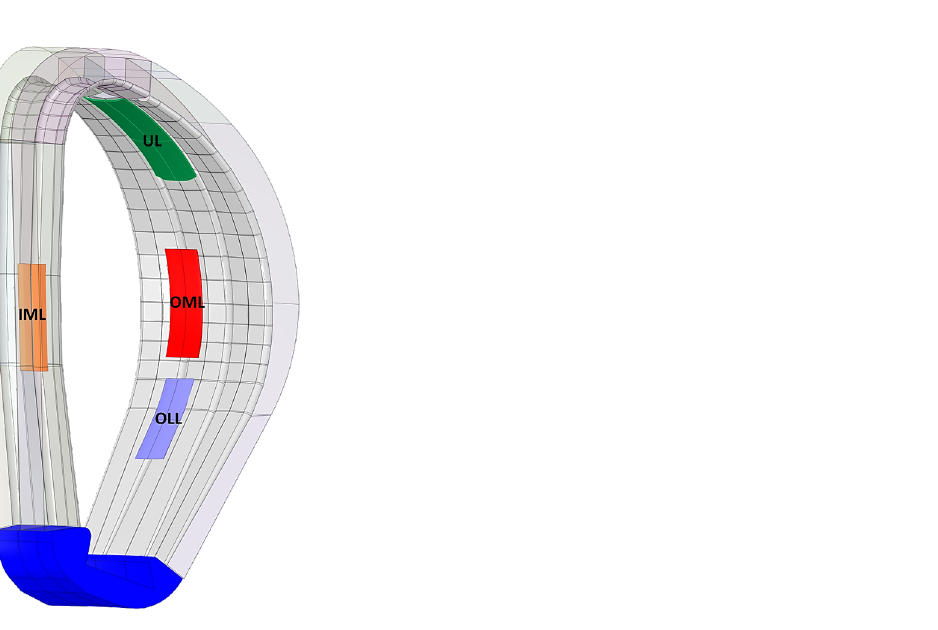
Figure 1. Position of EU-DEMO first wall limiters in a sector of 22.5°. Orange: inner midplane limiter (IML), green: upper limiter (UL), red: outer midplane limiter (OML), indigo: outboard lower limiter (OLL)